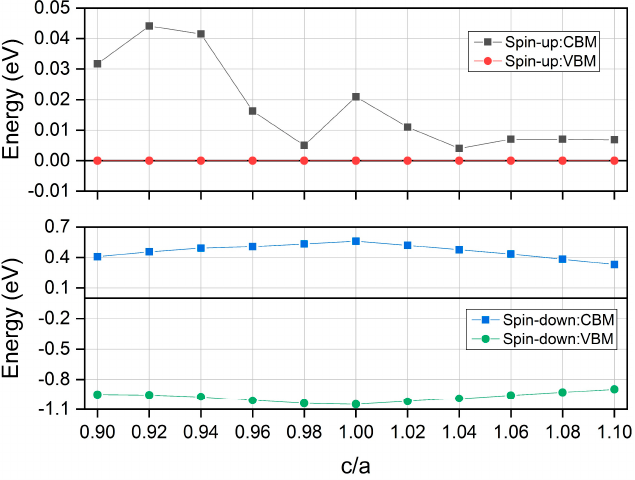
Figure 7. The calculated conduction band minimum (CBM) and valence band maximum (VBM) for the half Heusler compound MnPK in both spin directions under different tetragonal strains.